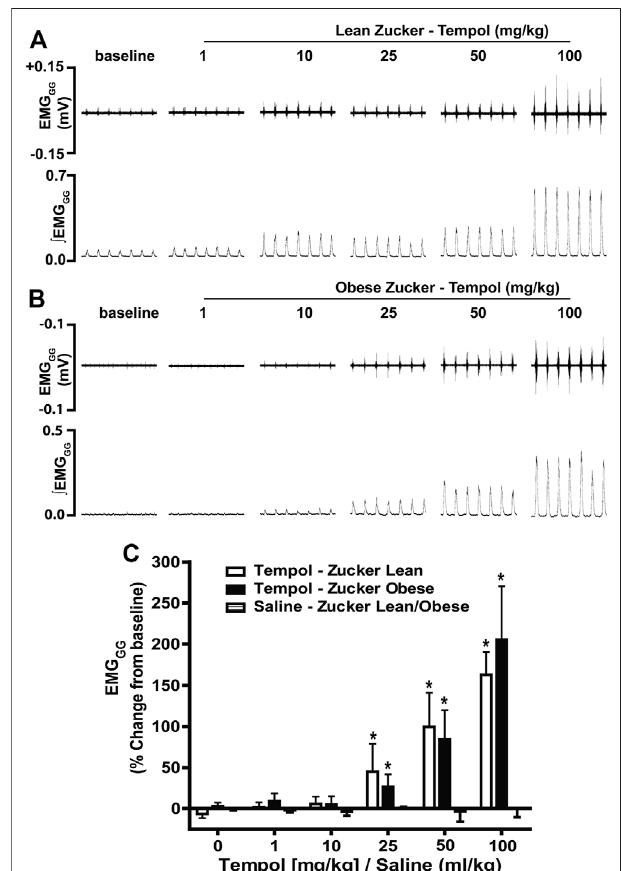
FIGURE 1 | Tempol dose-dependently increased genioglossus muscle activity (EMG GG ) in obese and lean Zucker rats. (Panels A and B) : Representative recordings of raw and integrated EMG GG activities from iso fl urane anesthetized spontaneously breathing obese (A) and age- matched lean (B) Zucker rats respectively, showing the cumulative dose- dependent effects ofTempol (1 – 100 mg/kg). (Panel C) : Percentage